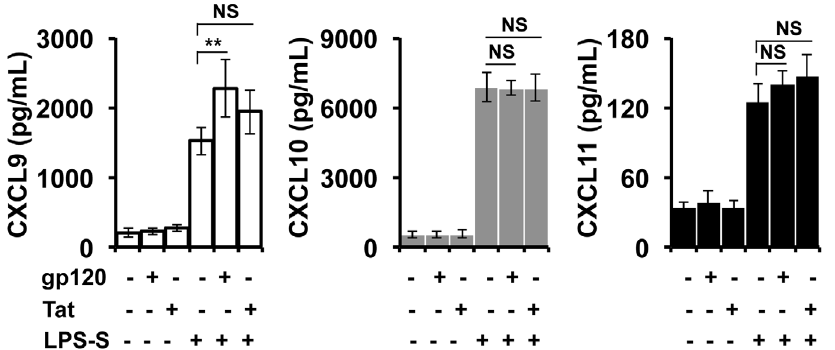
Figure 5. HIV-1 proteins enhance LPS-S activity in induction of CXCR3-associated chemokine by human hepatocytes . Huh7.5.1 cells in 24-well plates were treated with HIV-1 gp120 (1.0 m g/mL) or Tat (1.0 m g/mL) in the presence or absence of LPS-S from LPS-stimulated PBMCs (1:10 dilution) for 24 h. After stimulation, cell-free supernatant was harvested and then subjected to an ELISA assay to determine protein levels of CXCL9, CXCL10, and CXCL11. Horizontal bars represent mean 6 SD of chemokine protein levels from triple wells of each dose. Note that different Y-axis values among CXCL9, CXCL10 and CXCL11 are used. p , 0.05 indicates significant differences. NS, not significant, **, p , 0.01; and *, p , 0.05.